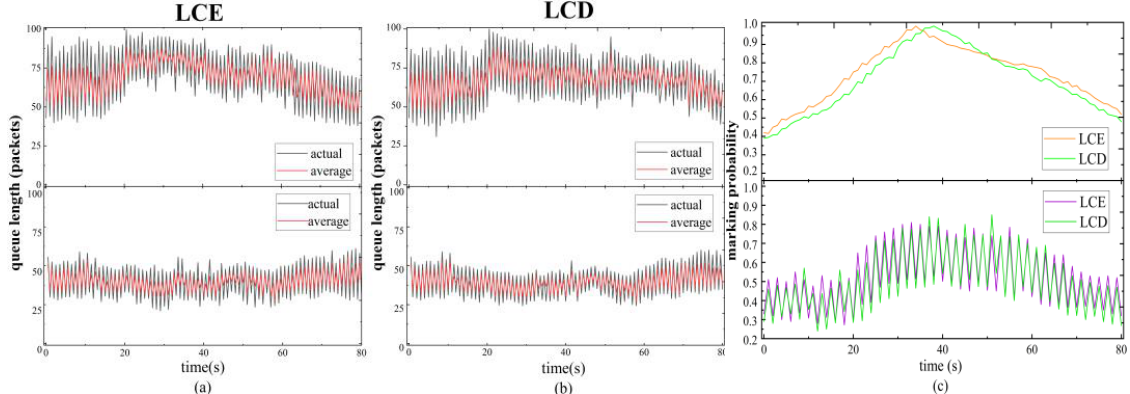
Figure 9. Comparison of queue length and marking probability under YELLOW between LCE and LCD. ( a ) the actual and average queue length of under LCE; ( b ) the actual and average queue length of under LCD; ( c ) the marking probability under LCE and LCD;